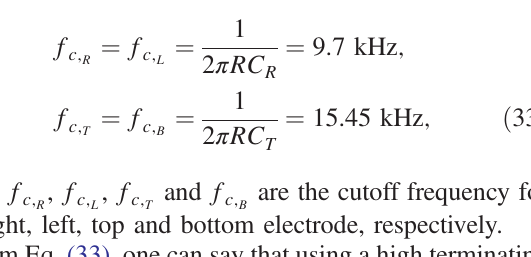
FIG. 18. (a) Pickup model used for the calculation of the capacitance matrix, from CST EMS. (b) Pickup model used for the simulation in the time domain, from CST PS.